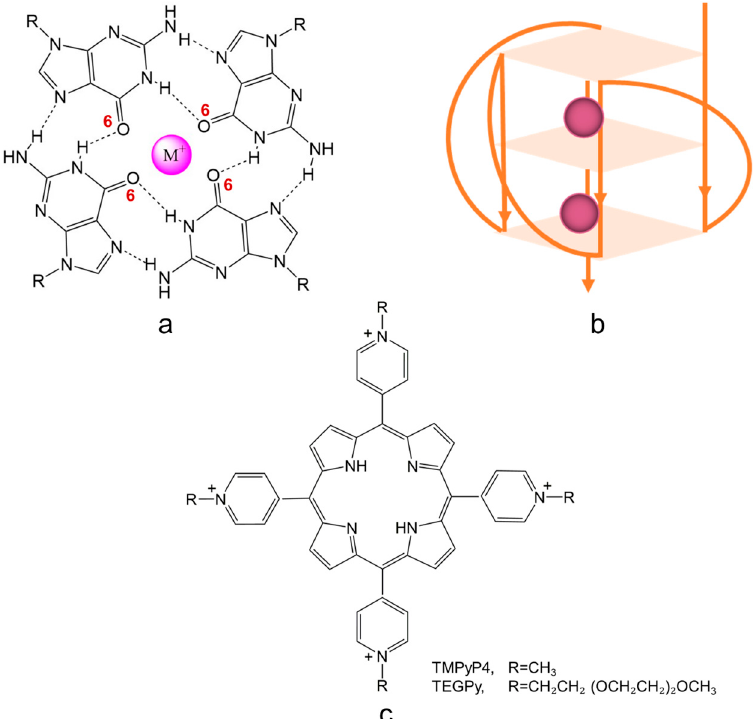
Figure 1. Schematic illustration of ( a ) a G-quartet stabilized by monovalent cations (such cations are usually coordinated to the inwardly pointing carbonyl oxygen atoms (O6) of the guanine bases forming the quartet); ( b ) a G4 structure with parallel conformation; and ( c ) G4 binding ligands with aromatic structural features; R=CH 3 or CH 2 CH 2 (OCH 2 CH 2 ) 2 OCH 3 , representing TMPyP4 and TEGPy, respectively.